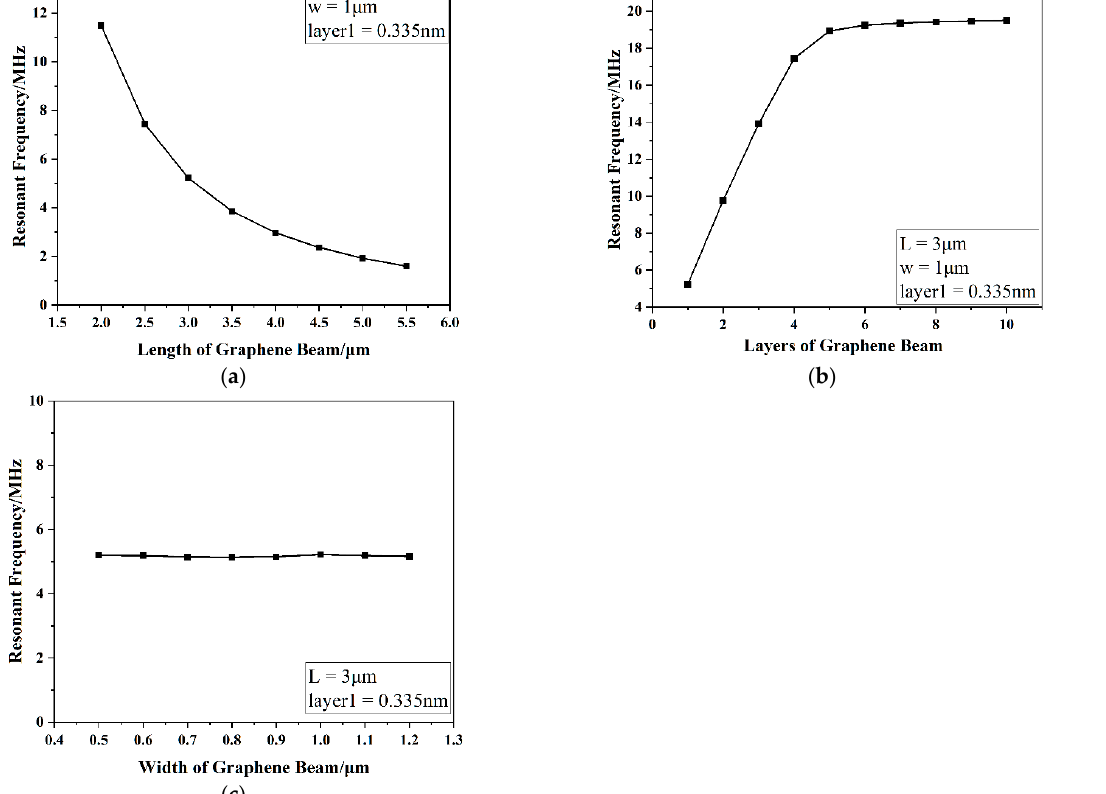
Figure 9. Sensitivity versus length of the graphene resonant beam. 4. Conclusions In this study, a graphene resonant gyroscope structure with a graphene beam reso- nator was designed. Theoretical analyses and finite element simulations of the graphene resonant beam structure and the graphene resonant gyroscope were carried out. The fun- damental frequency of the graphene resonant gyroscope was determined to be more than 20 MHz, and the sensitivity of the angular velocity was able to reach 22,990 Hz/°/h. It was found that the length and thickness of the graphene resonant beam both affected the sen- sitivity of the sensor. The sensitivity decreased upon increasing both the length and the thickness of the graphene resonant beam. This work provides a theoretical basis for the